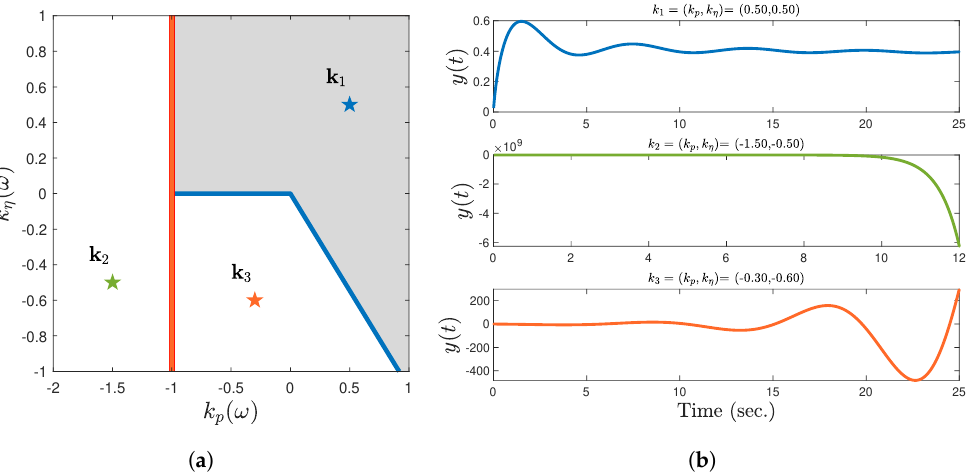
Figure 4. Stability analysis of system (11). ( a ) Stability region (gray) of the closed-loop system with µ = 0.3. ( b ) Time response for control gains inside different regions on the parameter’s